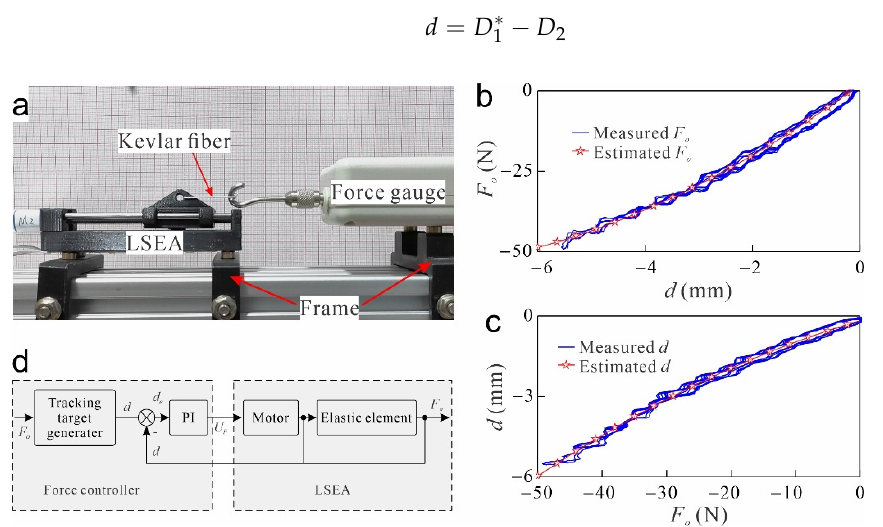
Figure 6. Control model identification experiment. ( a ) Experimental platform of the LSEA system; ( b ) estimation of the actuating force F 0 ; ( c ) approximation of the control target of the spring deformation d ; ( d ) controller structure of the LSEA system.